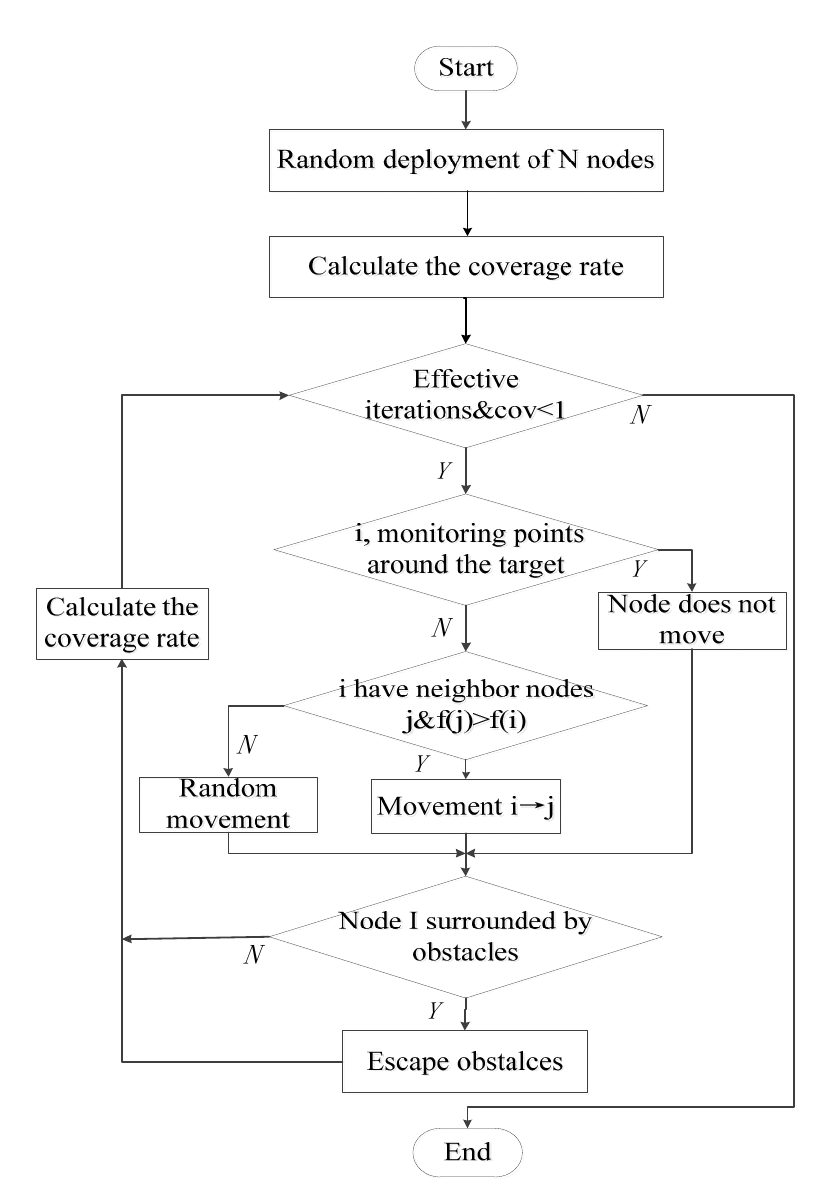
Figure 3. Flowchart of the RAWS algorithm.